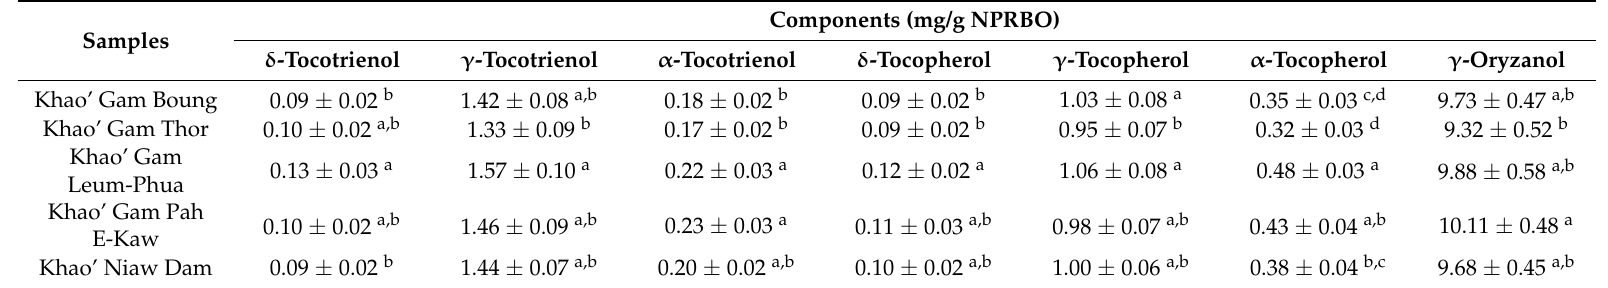
Table 1. Tocotrienol, tocopherol, and γ -oryzanol contents in NPRBOs.